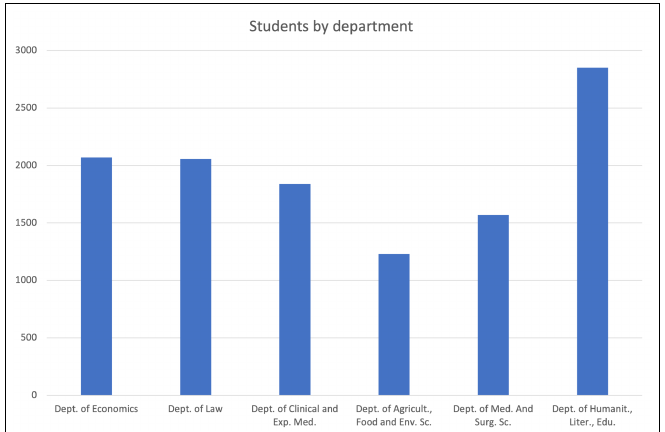
Figure 4. Total students enrolled.